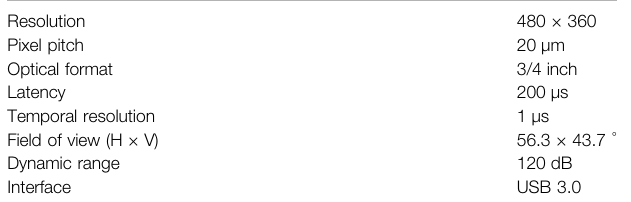
TABLE 3 | Speci fi cations of the Evaluation Kit Gen3 HVGA-EM sensor used for this work. Resolution